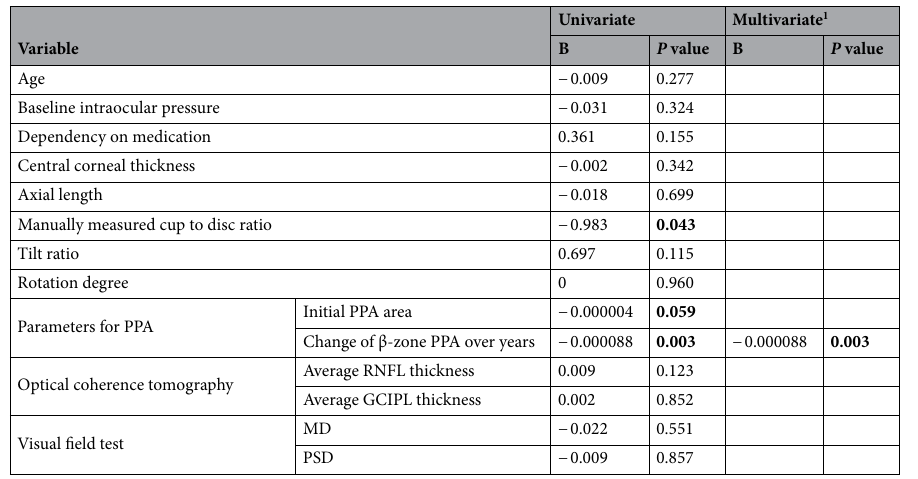
Table 6. Linear regression analysis to determine the correlation between variables and visual field (VF) defect progression (trend- based GPA) in temporal VF defect group (N, 39). GPA guided progression analysis, MD mean deviation, PSD pattern standard deviation, RNFL retinal nerve fiber layer, GCIPL ganglion cell inner plexiform layer, PPA peripapillary atrophy. Average RNFL and GCIPL thicknesses were corrected with the Littmann’s formula. Only variables with a P value < 0.10 in the univariate analysis were included in the multivariate model. Bold font indicates significant P values ( P < 0.05).